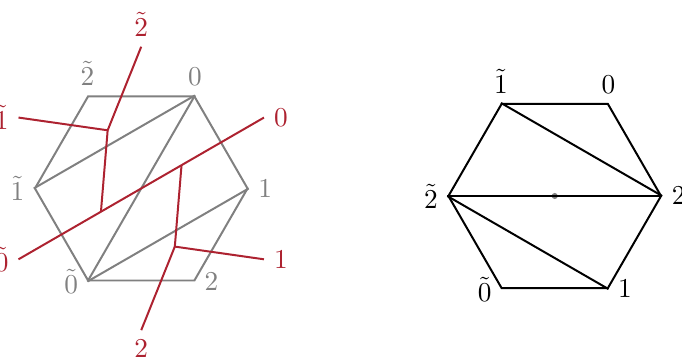
Figure 3 . The dual graph of a triangulation (left) and a triangulation in the ordering (021~0~2~1)